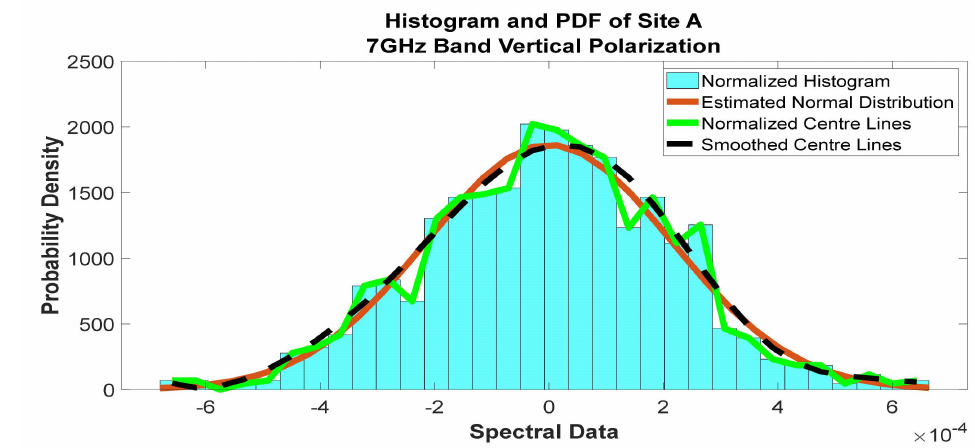
Figure 23. Histogram and PDF of the frequency scan for site A at 7 GHz vertical polarization.